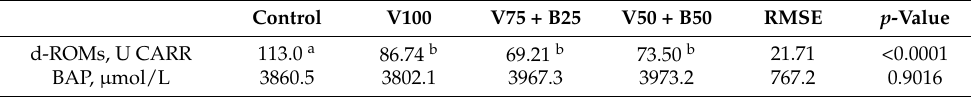
Table 6. Hemolymph oxidative stress profile of black soldier fly larvae at 20 days of age. Control V100